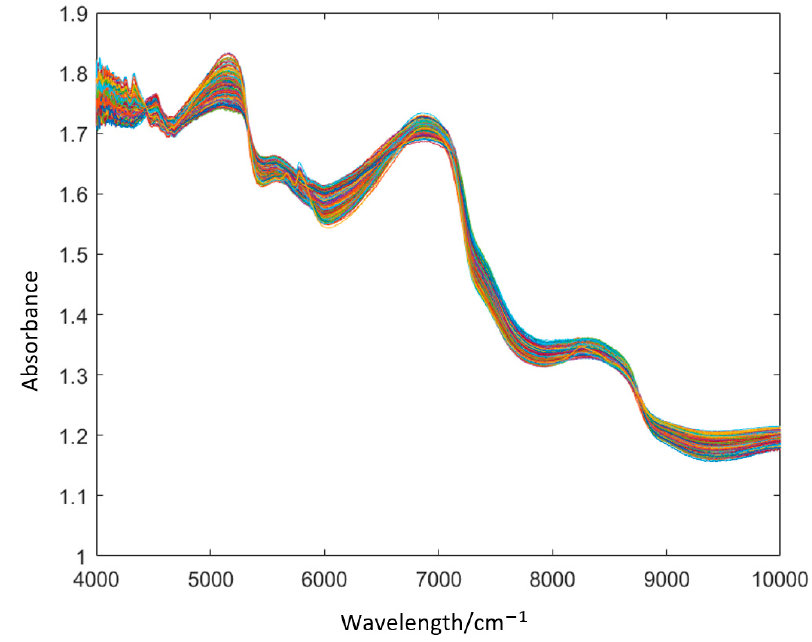
Figure 1. NIR spectra of the pork meat samples preprocessed by MSC.